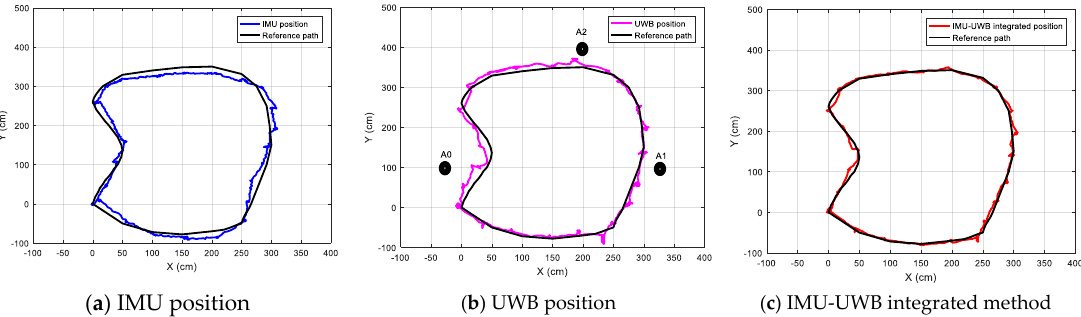
Figure 14. The measured locations for walking along an arbitrary path.